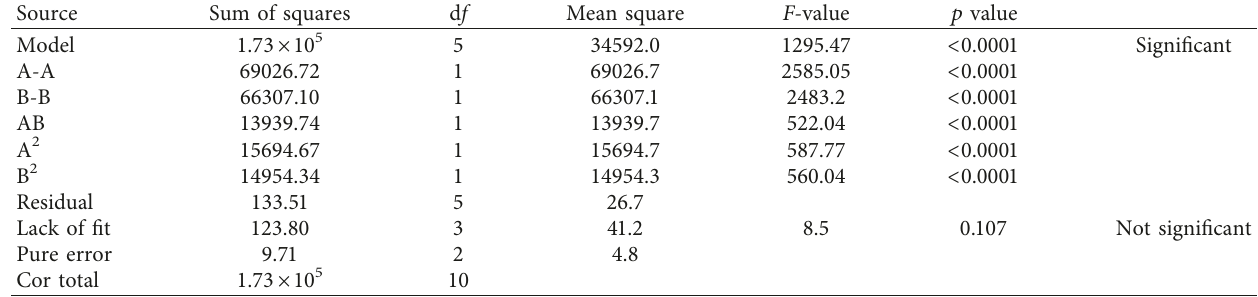
Table 2: Estimated coefficients of multiple determinations ( R 2 ) for particle size using coded values.